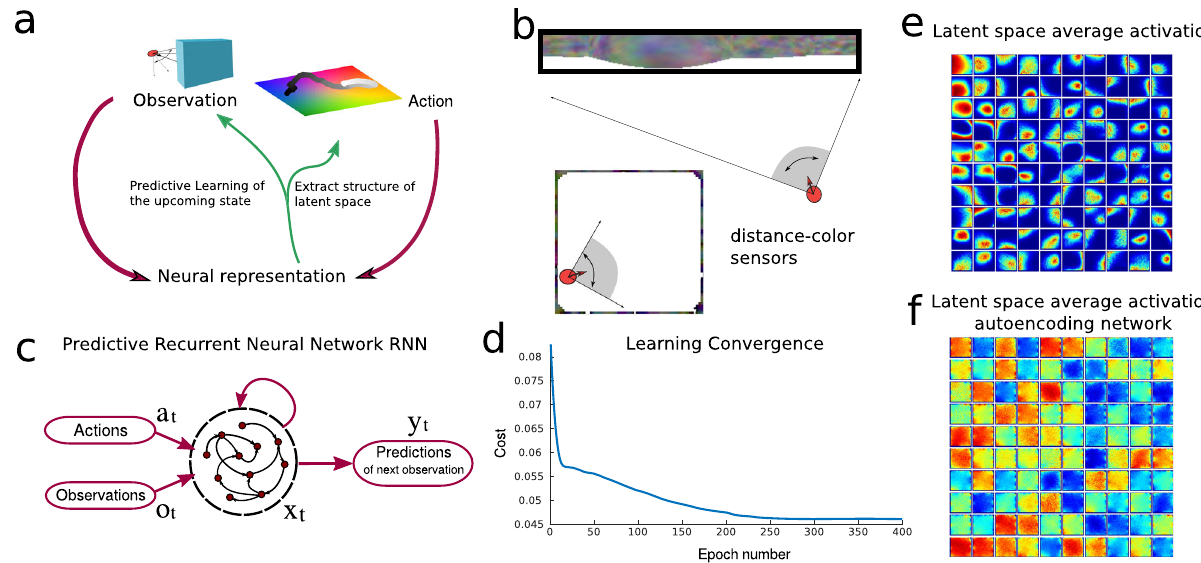
Fig. 2 Predictive network solving an exploration task. a Information fl ow diagram of the task: an agent explores a two-dimensional environment (latent space) through actions and receives observations regarding it. The network ’ s task is to predict the next sensory observation. By learning to do so it recovers information regarding the underlying hidden latent space. b Illustration of the agent with sensors in the square environment where the walls have been colored (cfr. Methods). The sensors span a 90 o degree angle and register the color and distance of the wall along their respective directions. c Diagram of the predictive recurrent neural network: the network receives actions and observations as inputs and is trained to output the upcoming sensory observation. d Cost during training for the network (cf. Methods). e Average activity of 100 neurons (each of the 100 neurons average activity is showed in one of the small 100 quadrants) against the x , y coordinates of the environment, showing place-related activity. f Same as panel e for a RNN trained to autoencode its input